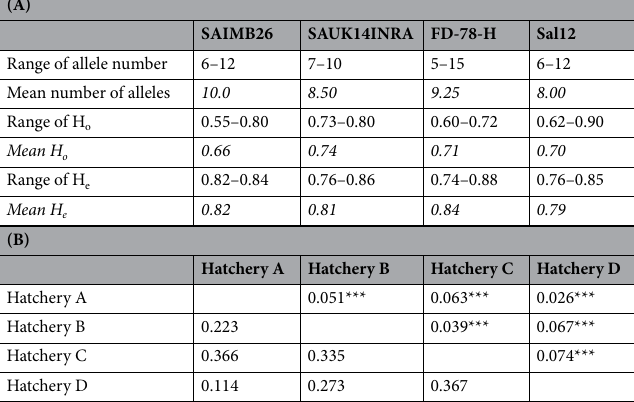
Table 4. (A) Allele number, observed heterozygosity (Ho) and expected heterozygicity (He) for each of the four loci in the samples provided by the four participating hatcheries; (B) Pairwise F ST (above diagonal) and pairwise Nei’s genetic distances (below diagonal), between the four hatcheries based on the analysis of four microsatellite loci. Asterisks indicate statistical significance at p < 0.001. Mean values are in